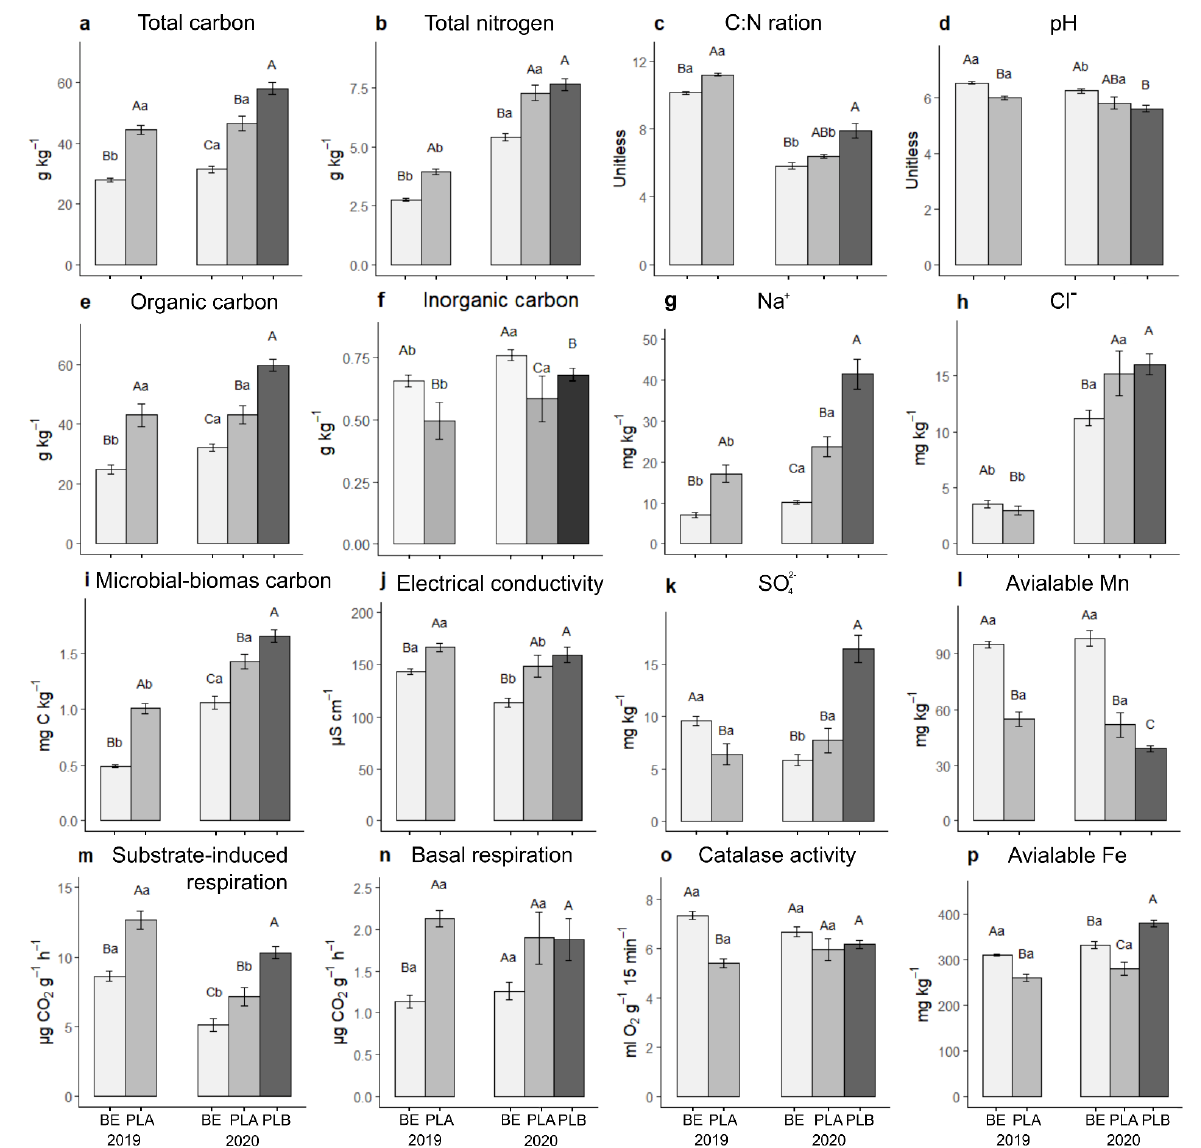
Figure 2. Summary statistics of the topsoil properties at study sites in years 2019 and 2020 (BE = Bedrich “plantation forest”; PLA = Placek A “managed forest”; PLB = Placek B “natural forest”). Different upper-case letters indicate significant differences among sites in a particular year at p = 0.05 (the Tukey’s Honest Significant Difference test); different lower-case letters indicate significant differences between years at p = 0.05 (one-sided paired t-test).